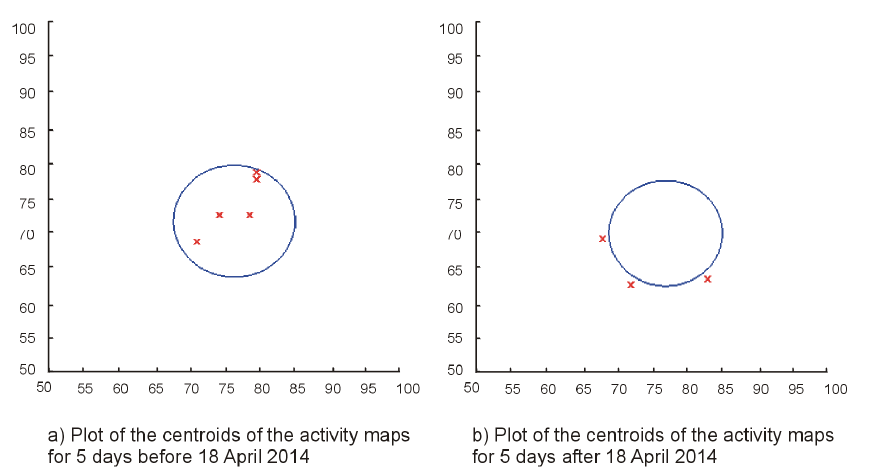
Figure 9. CASAS HH-126 dataset: Plot of the centroids of the activity maps for the time slice (07.00 am–07.59 am). ( a ) Five days before 18 April 2014 ( b ) Five days after 18 April 2014. The circle is the SBC of the centroids of the activity maps created for the same time slice during the reference interval (01.02.2014–10.04.2014).